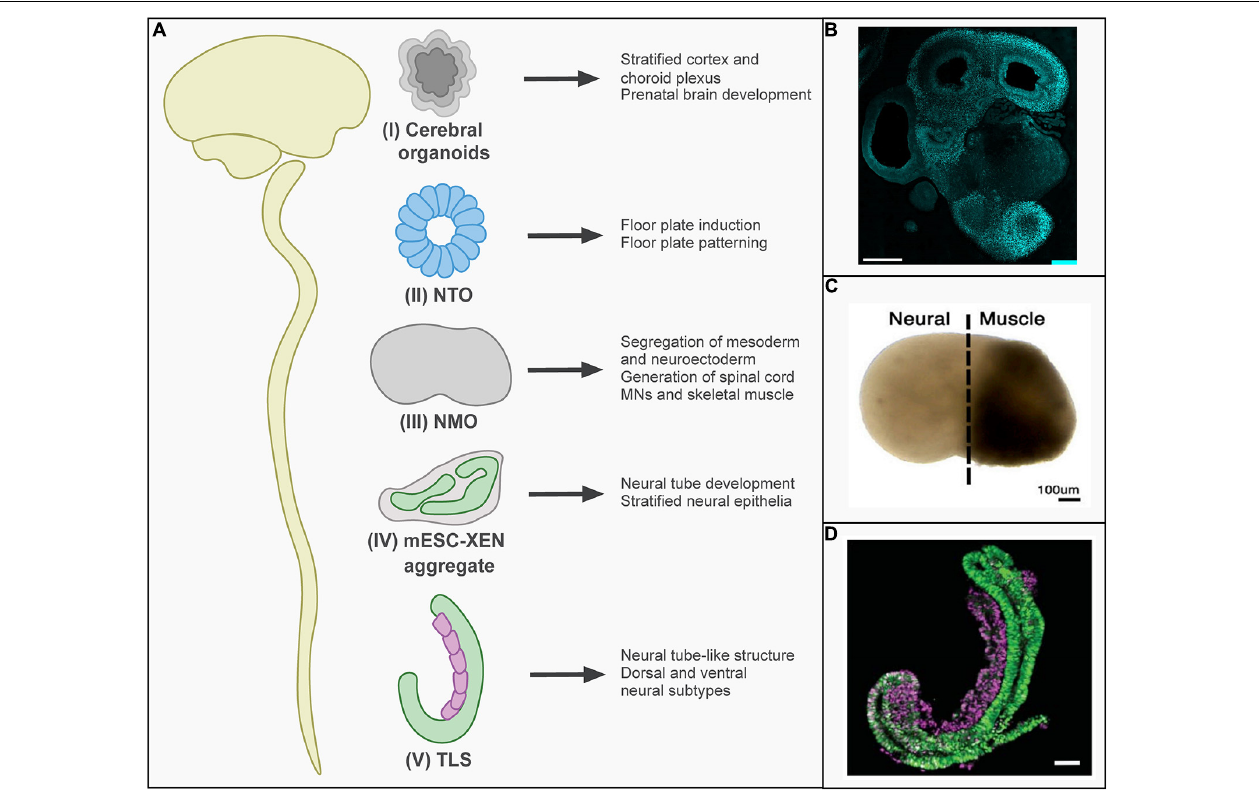
FIGURE 2 | In vitro models of neural tube development. (A) In vitro stem-cell-based models reflecting different stages of neural tube development have been established: (I) Cerebral organoids recapitulate the cortex and choroid plexus of the brain. (II) Neural tube organoids (NTOs) have been used to examine the role of mechanistic forces on floor plate induction and patterning. (III) Neuromuscular organoids (NMOs) recapitulate thoracic/lumbar neural tube development. In the first 5 days, a segregation between neuroectoderm and mesoderm region occurs. At day 20, motor neurons (MNs) and myoblasts were present. (IV) mESC-XEN aggregates consist of stratified neural epithelia and were shown to follow in vivo mouse development. (V) Trunk-like structures (TLS) recapitulate neural tube development and form neural tube-like structures that consist of dorsal and ventral neural subtypes. (B) Representative image of cerebral organoids showing immunostaining for FOXG1 to visualize differentiation toward forebrain identity (scale bar 500 µ m) [reprinted from Renner et al. (2017), with permission from John Wiley and Sons]. (C) Representative image of neuromuscular organoids [reprinted from Faustino Martins et al. (2020), with permission from Elsevier]. (D) Representative image of trunk-like structures expressing markers for mesodermal (purple) and neural (green) tissue (scale bar 100 µ m) [reprinted from Veenvliet et al. (2020), with permission from AAAS.).